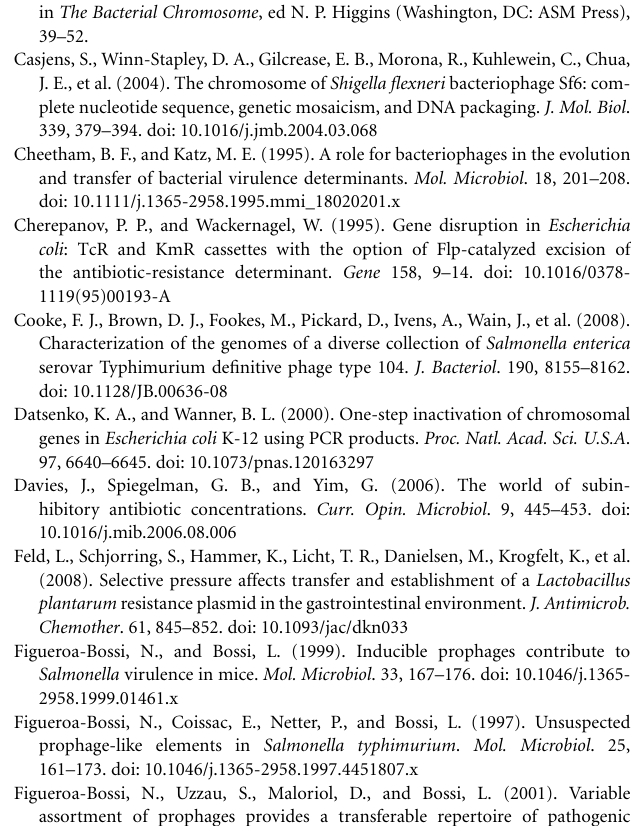
Figueroa-Bossi, N., and Bossi, L. (1999). Inducible prophages contribute to Salmonella virulence in mice. Mol. Microbiol . 33, 167–176. doi: 10.1046/j.1365-